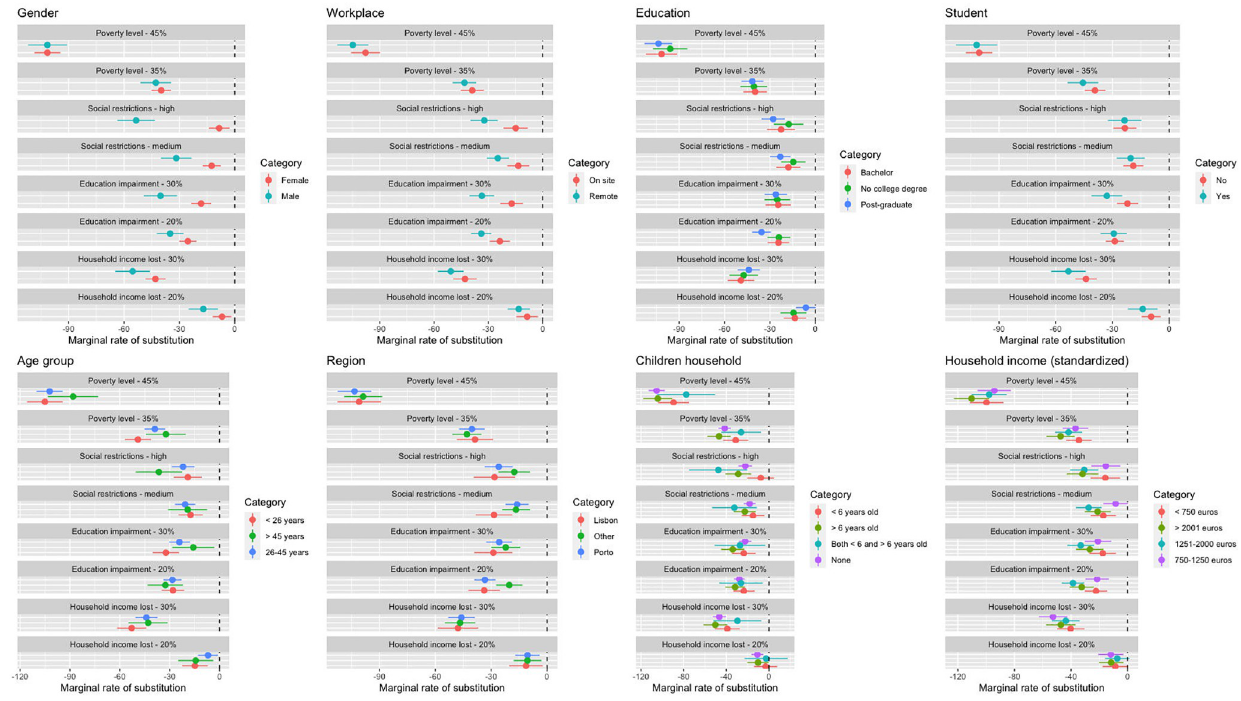
Fig 2. Marginal rate of substitution (MRS) by